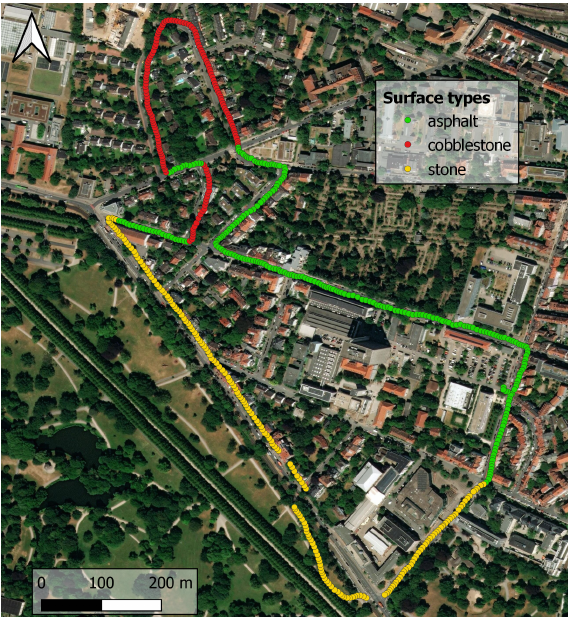
Figure 5. The test route is used to evaluate the different scores under different conditions. The colors encode the different surface types asphalt (green), stone (yellow) and cobblestone (red). Source of basemap: ESRI